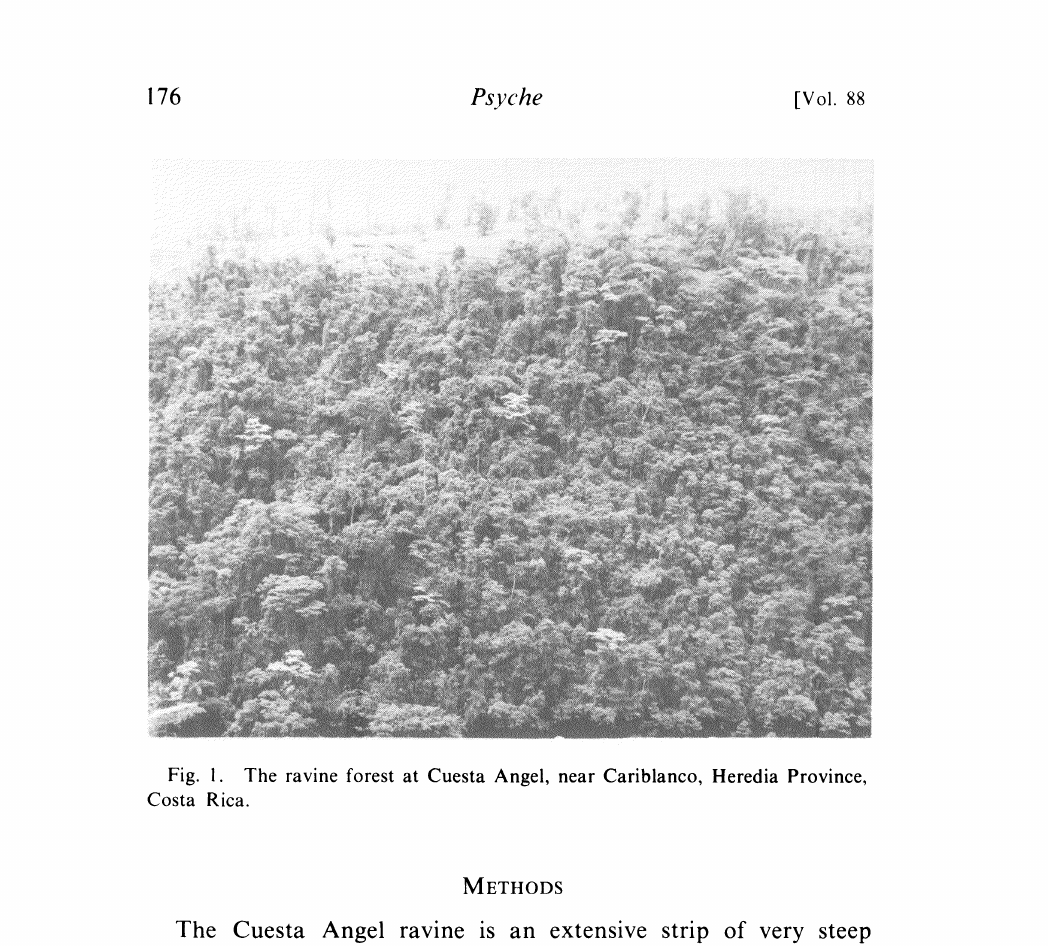
Fig. I. The ravine forest at Cuesta Angel, near Cariblanco, Heredia Province, Costa Rica.